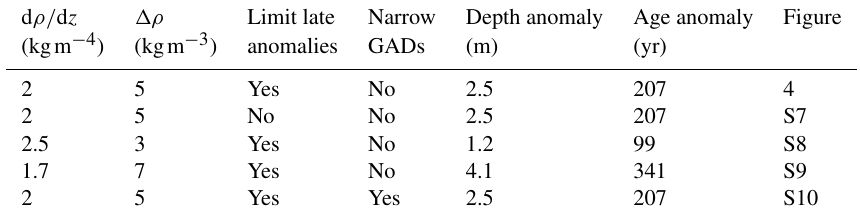
Table 1. Layering model parameters and resulting depth anomaly, age anomaly, and associated figure. The first row corresponds to the reference simulation and the sensitivity tests are below. The depth and age anomaly values refer to the standard deviation (1 σ ) of early trapping artifacts. These 1 σ values are half the 2 σ values mentioned in the corresponding figure